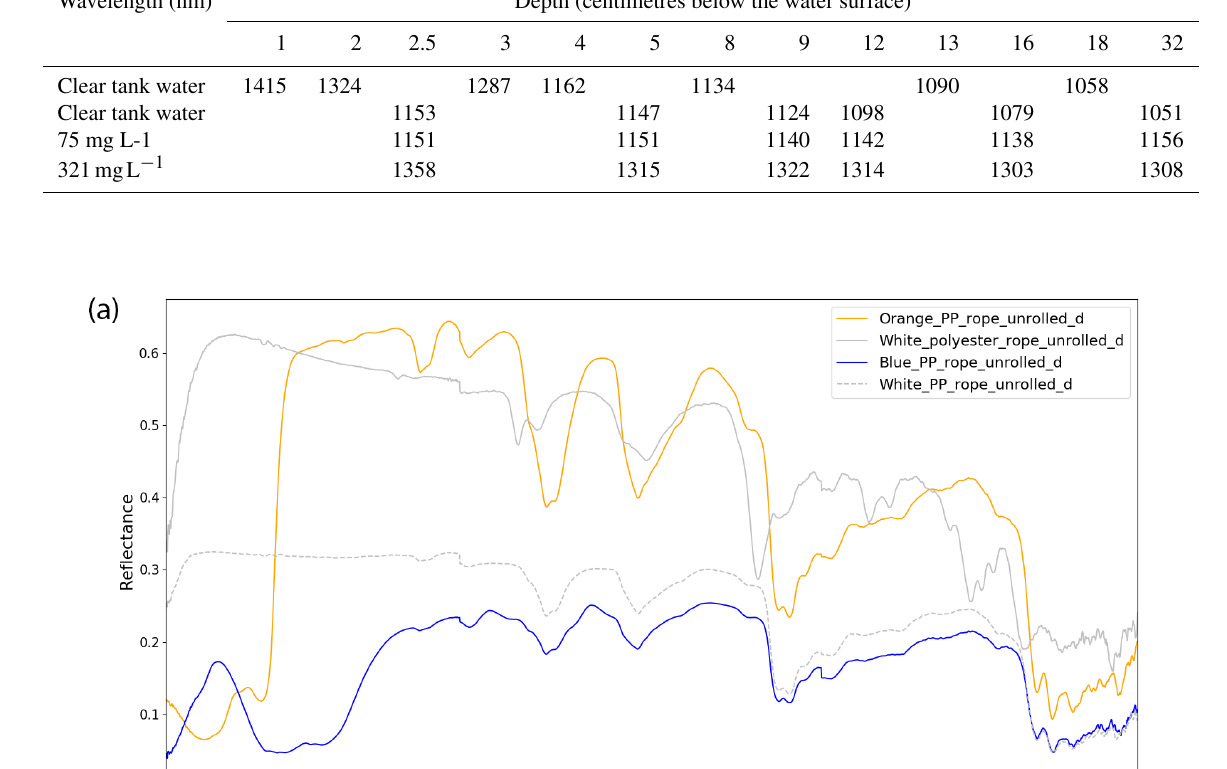
Table 4. Wavelength corresponding to a reflectance threshold of 0.001 for the orange place mat. Wavelength (nm)